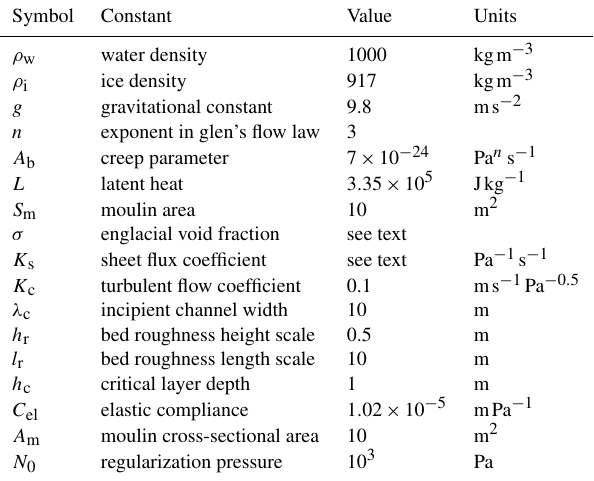
Table 1. Constants used in the subglacial hydrology model during integrated runs in the Russell Glacier area.